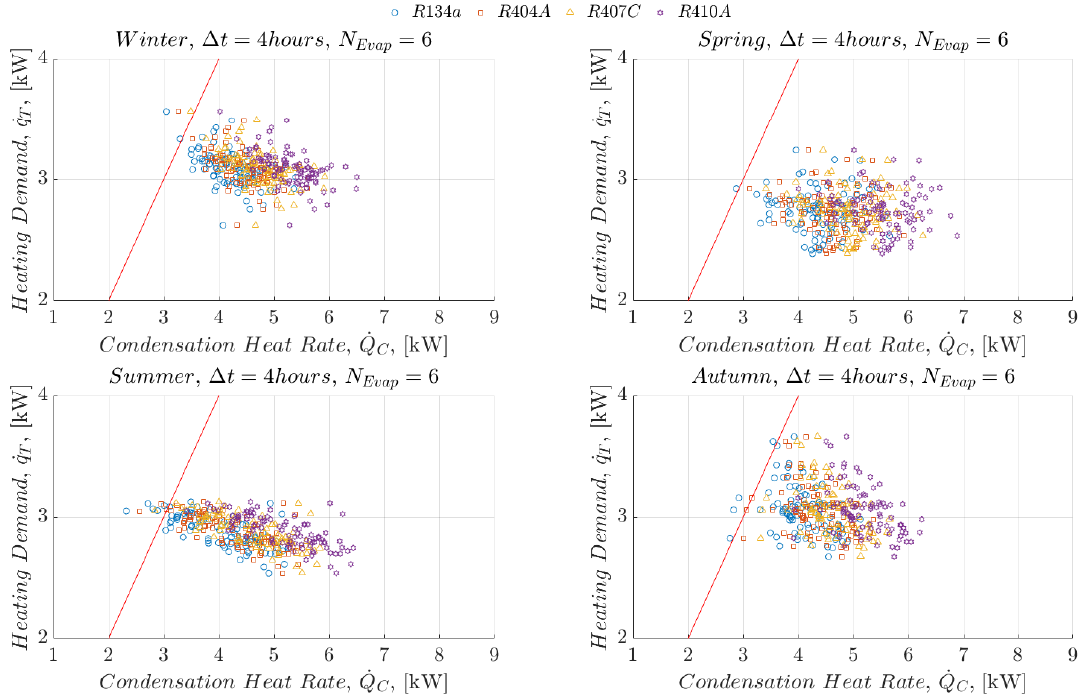
Figure 9. Thermal capacity seasonal density rate for all refrigerants and six collectors during 4 hours.